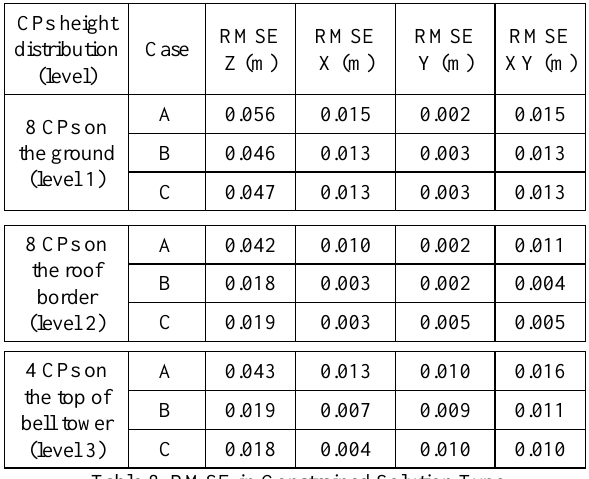
Table 8. RMSE in Constrained Solution Type 4.4 Roof bundle adjustment self- calibration results Camera calibration parameters, computed in the different